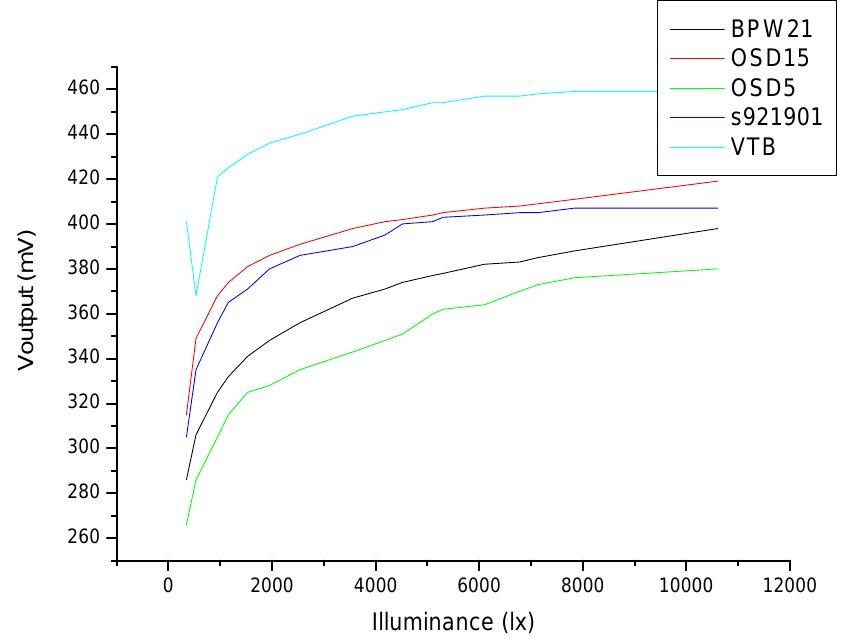
Figure 5. Curves of response of the different photodiodes analyzed, showing the voltage measured in the 0.1 Ω shunt depending on different illuminance